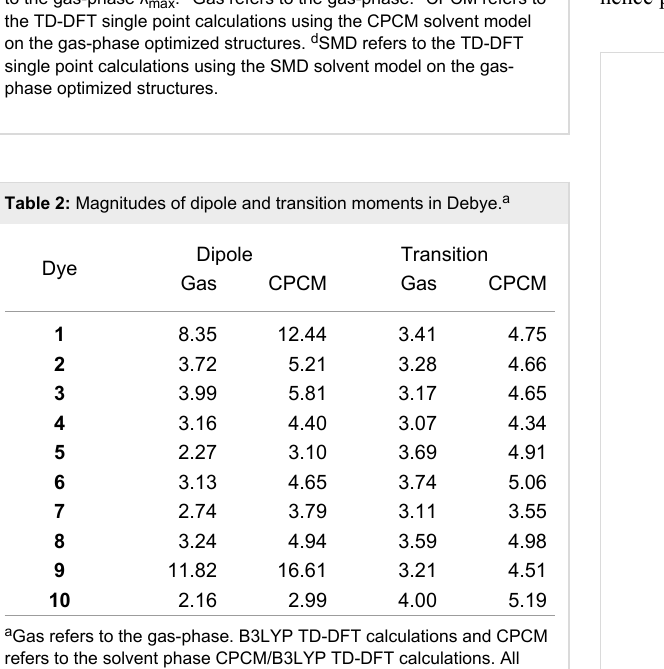
In the above representation the molecule lies in the xy plane, and is elongated along the x-axis, hence the z component only makes a very slight contribution towards the overall direction. In the case of the ground state dipole moments (Figure 3a), the observed vector differs depending upon the substituents